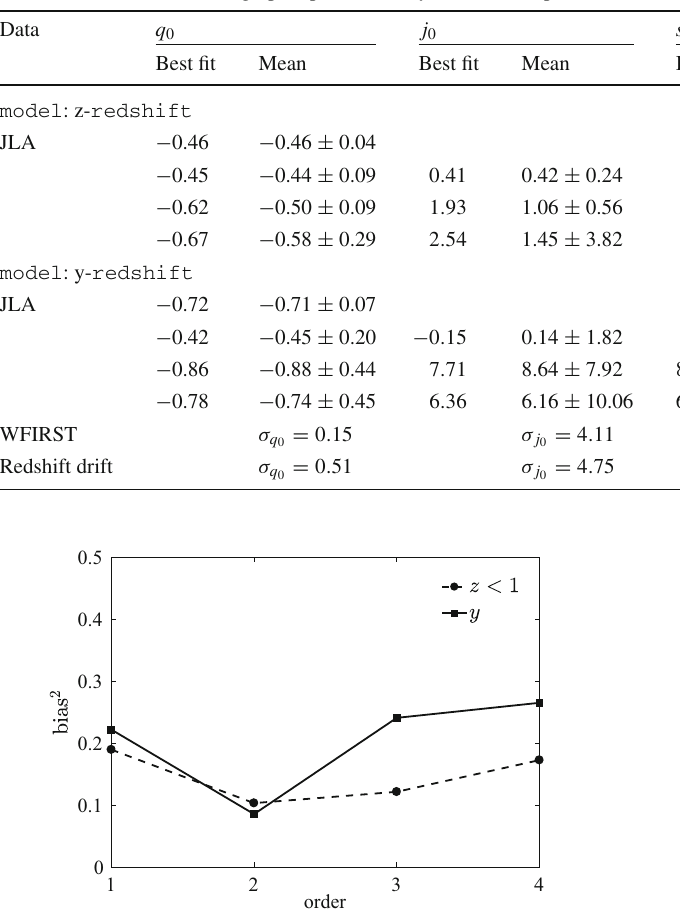
Fig. 5 Variance in the z -redshift and y -redshift of the JLA compilation with different cosmographic series